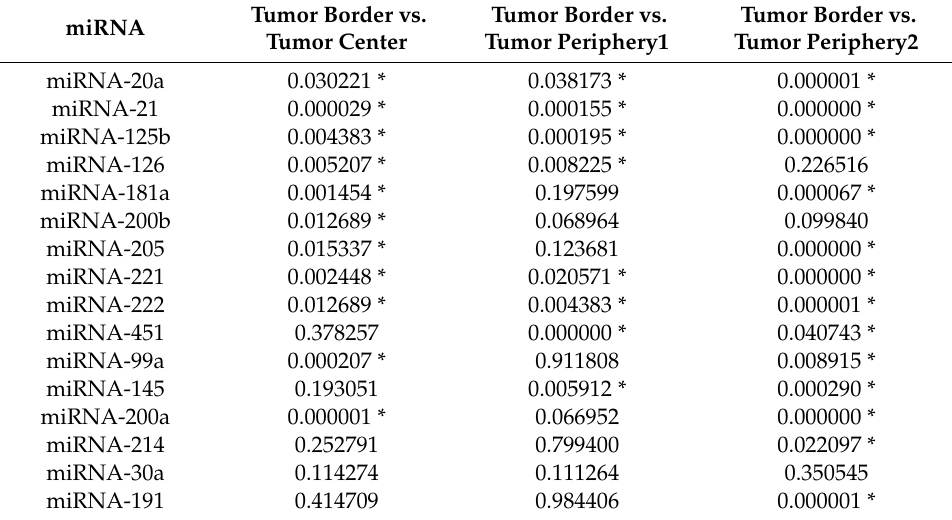
Table3. Significancelevelofdi ff erencesinmiRNAexpressionbetweenspecimenstakenfromintratumor areas and